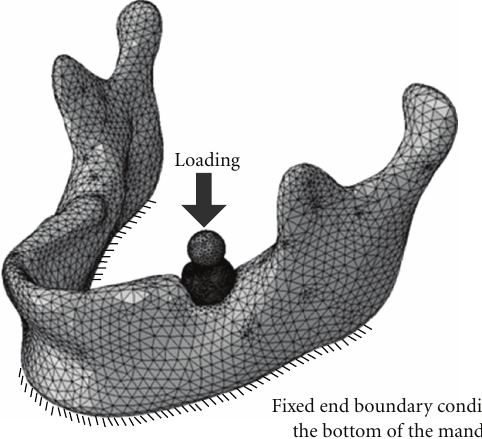
Figure 11: The meshed model (comprises of a restored tooth and a mandible) with description of loading and boundary conditions.